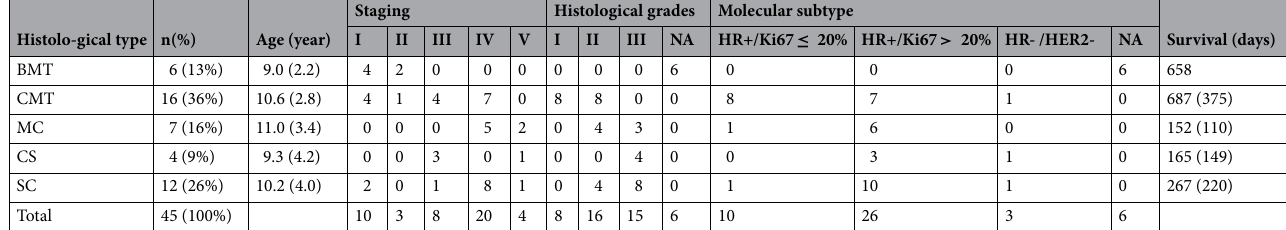
Table 1. The mean age of all the patients was of 10 years. The mean age for each histological subtype is pre- sented in Table 1with the standard deviation in brackets. Among the 45 cases of mammary neoplasm evaluated, 36% were carcinoma in mixed tumour (CMT; n = 16 ), 26% solid carcinoma (SC; n = 12 ), 16% micropapillary carcinoma (MC; n = 7 ), 13% benign mixed tumour (BMT; n = 6 ) and 9% carcinosarcoma (CS; n = 4 ). In rela- tion to the clinical staging, 44% of the carcinomas were classified with staging IV ( n = 20 ), 22% with staging I ( n = 10 ), 18% with staging III ( n = 8 ), 9% with staging V ( n = 4 ) and 7% with staging II ( n = 3 ). For the